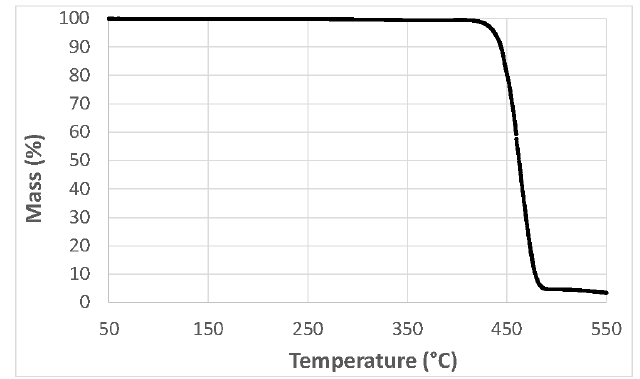
Figure 4. Evolution of PE mass versus temperature.